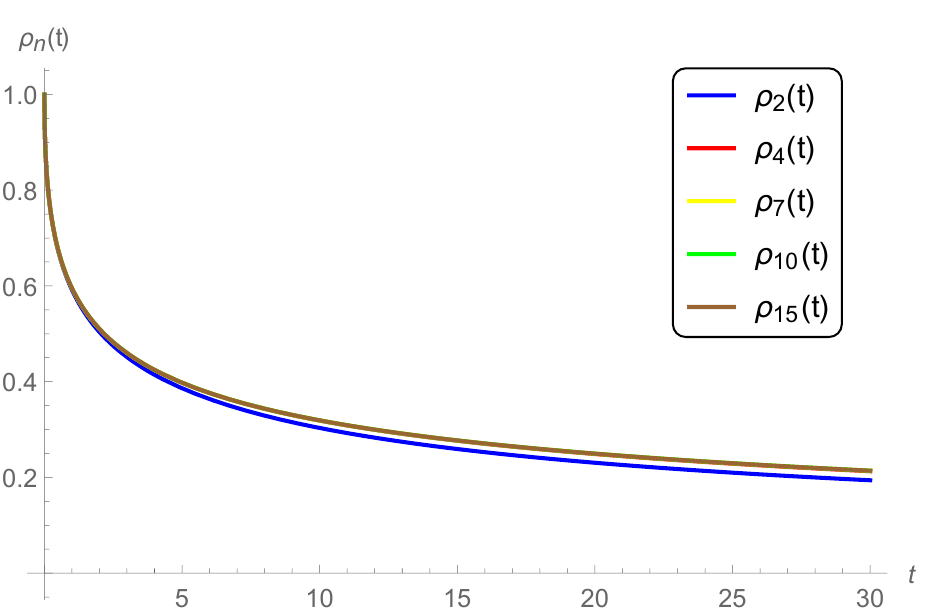
Figure 5. Graphs of the n -th approximate solution of (11), (12) with n = 2,4,7,10,15 and λ = 1, α = 0.5, and q =